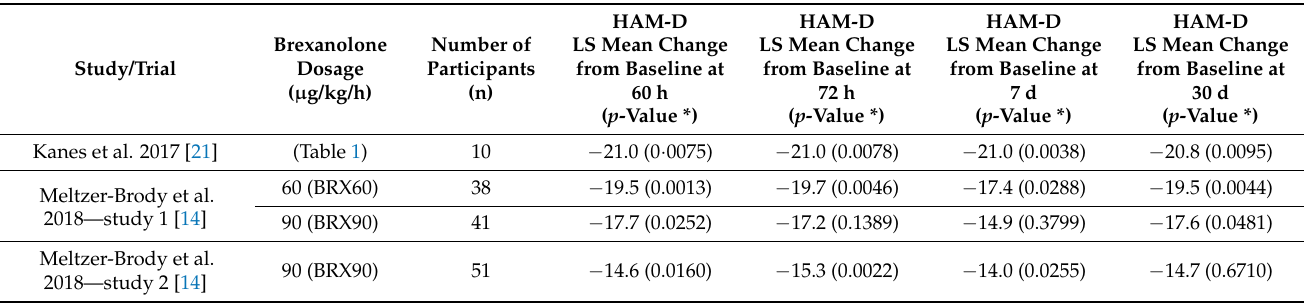
Table 2: Brief summary of 3 RCTs conducted to evaluate brexanolone efficacy with Hamilton Rating Scale for Depression (HAM-D) least square (LS) mean change from baseline at four timepoints (60 h, 72 h, 7 days, 30 days) post-commencement. * p -values obtained via two-sided t -test and compared to placebo group(s) for each study and timepoint. p > 0.05 is considered